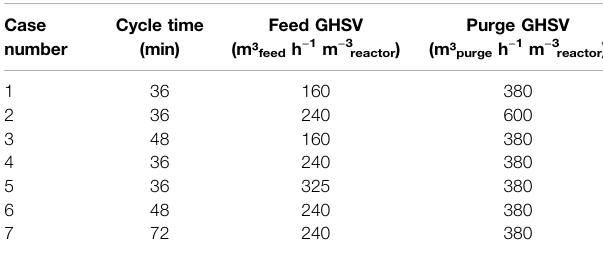
TABLE 4 | Parameters used for tuning of the SEDMES cycle